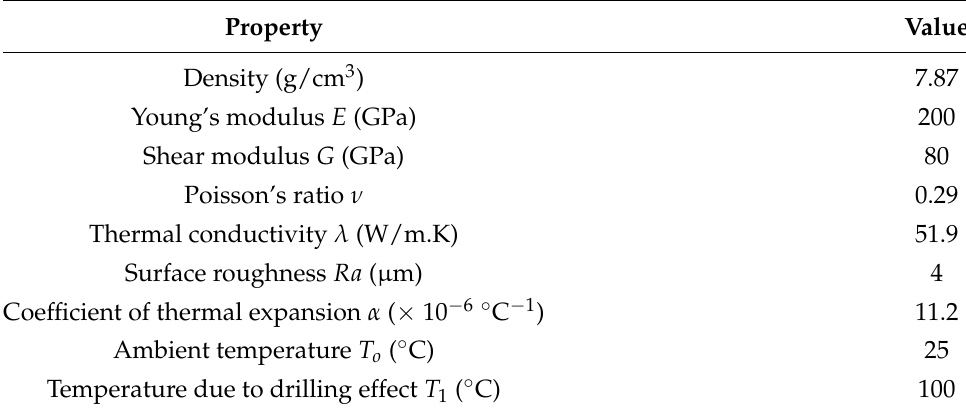
Table 1. AISI 1045 mechanical properties